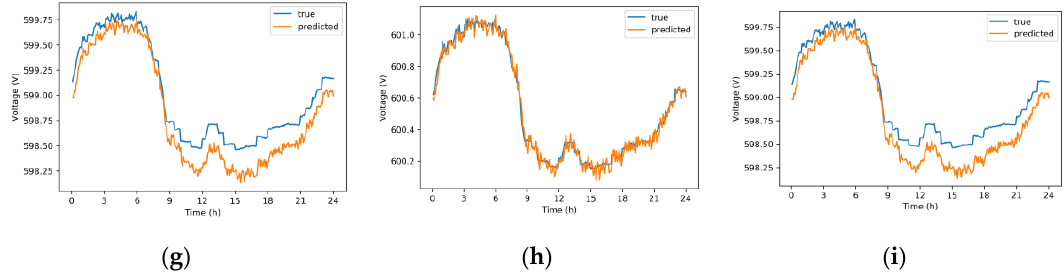
Figure 5. Conventional weighted least squares (WLS) voltage estimation results for: ( a ) bus 1; ( b ) bus 2; ( c ) bus 3; ( d ) bus 4; ( e ) bus 5; ( f ) bus 6; ( g ) bus 7; ( h ) bus 8; ( i ) bus 9.